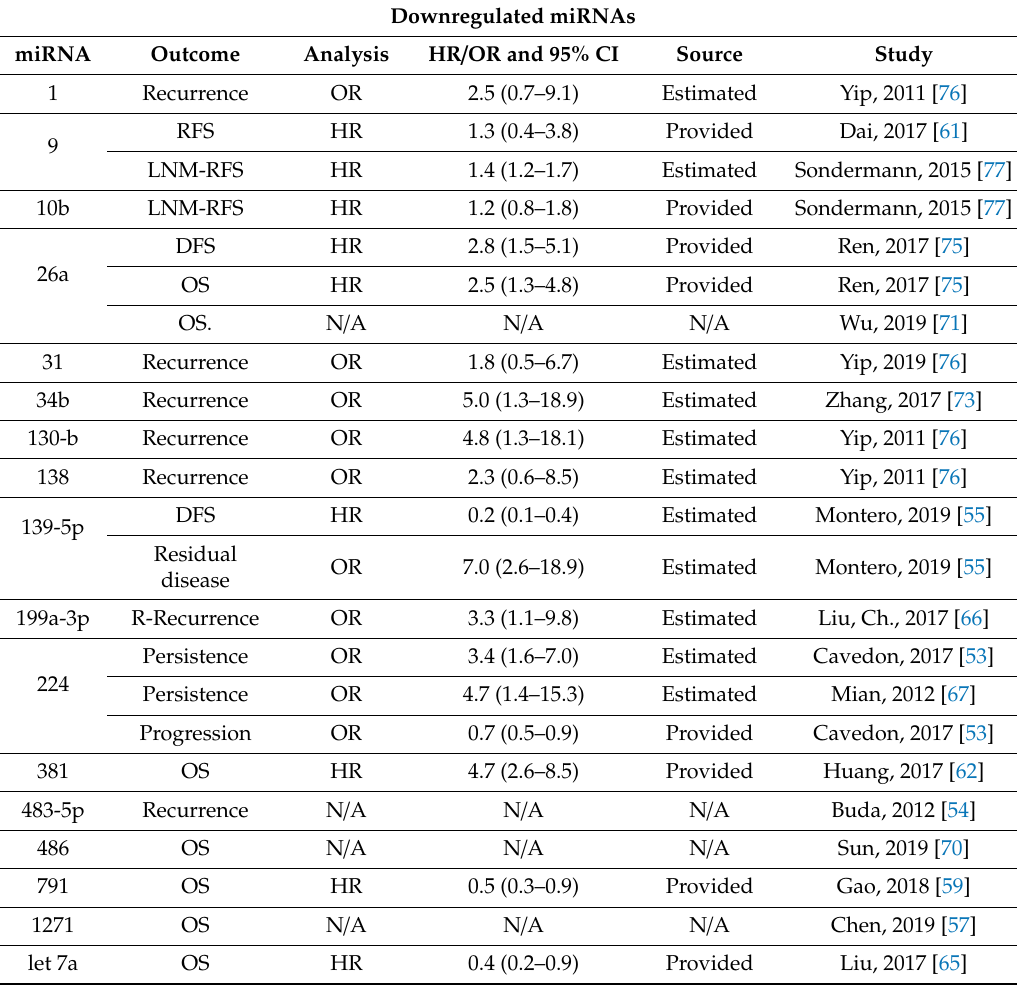
Table 3. Characteristics of downregulated